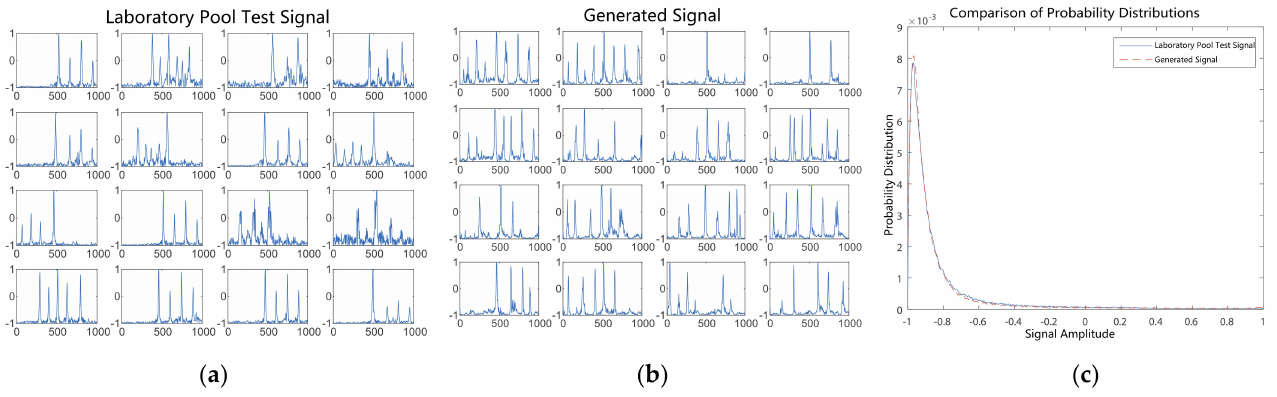
Figure 13. Comparison of generated signals with pool test signals after 200 epochs of training.